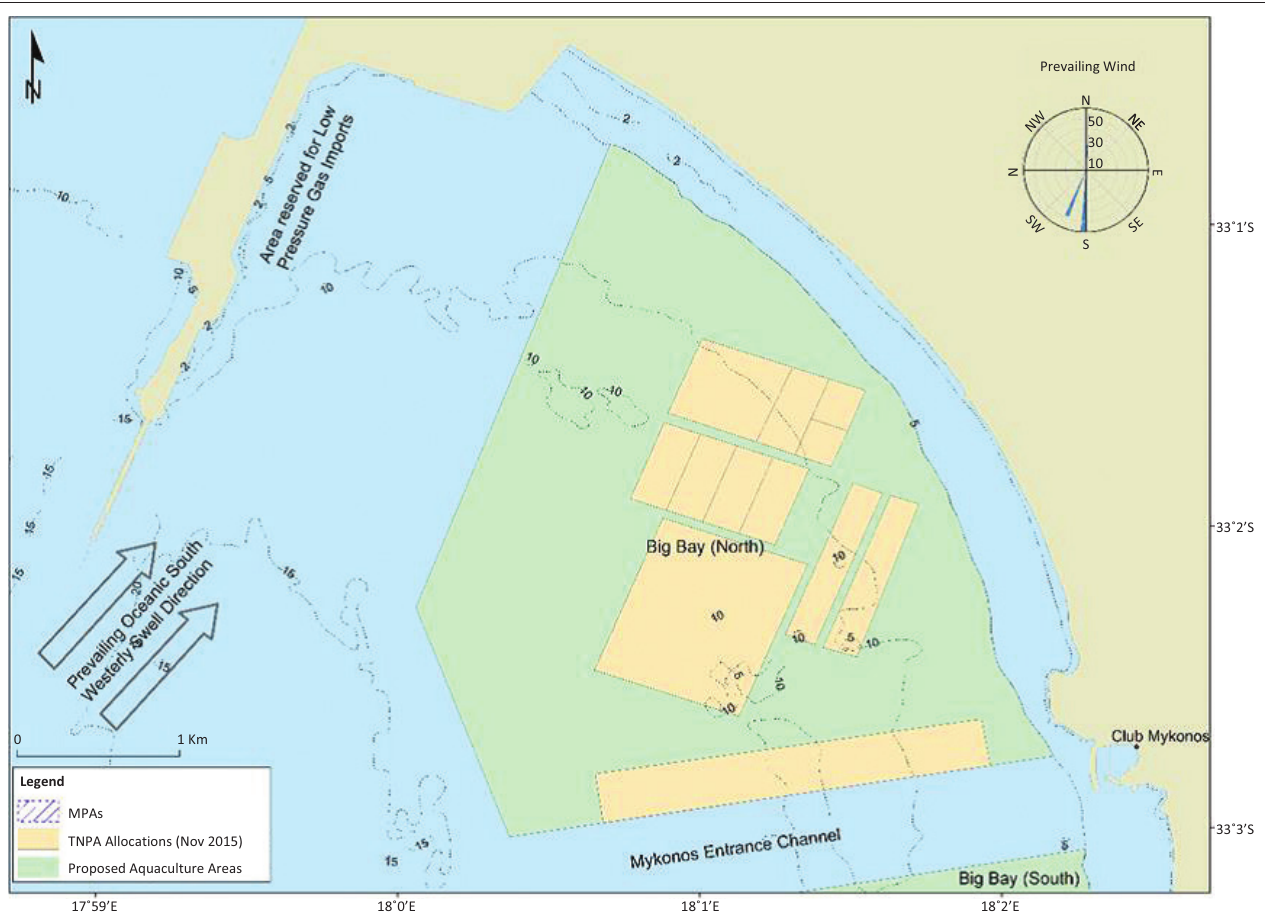
FIGURE 4: Proposed aquaculture development zones in Big Bay – North of